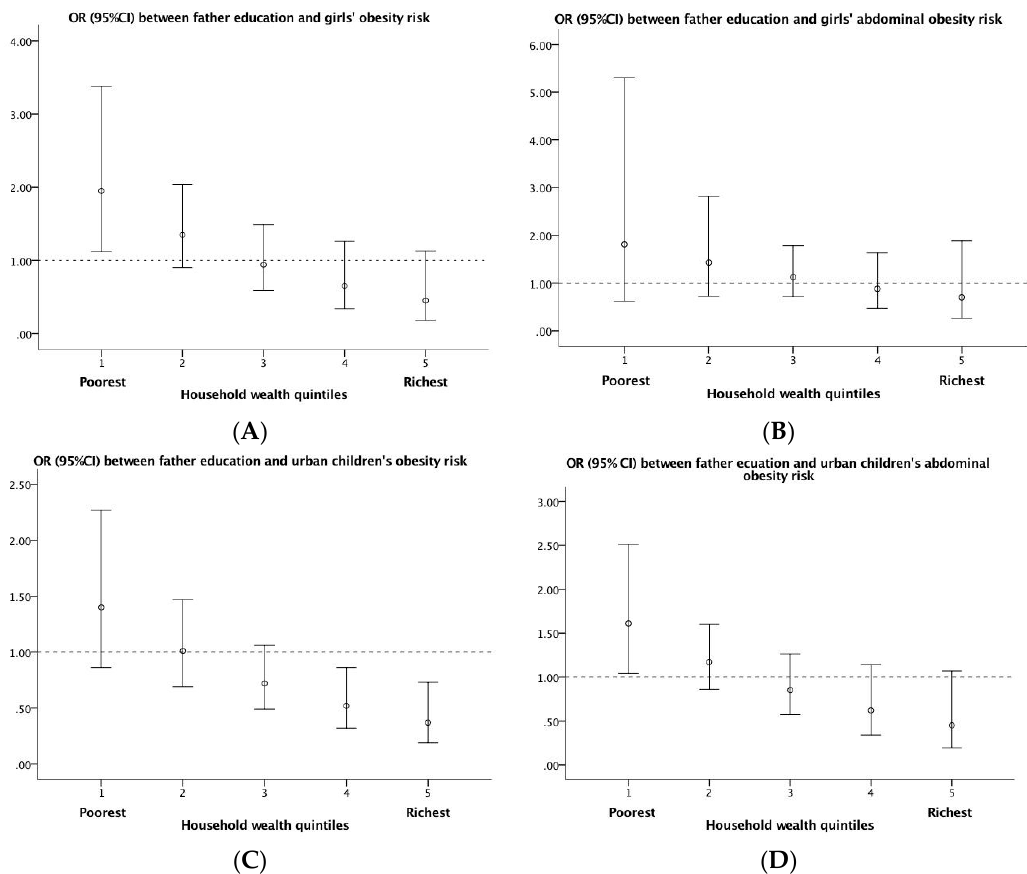
Figure 1. OR (95% CI) for father’s education level at different values of the household wealth quintile among girls and among urban children. ( A ) OR (95% CI) between father education and girls’ obesity risk; ( B ) OR (95% CI) between father education and girls’ abdominal obesity risk; ( C ) OR (95% CI) between father education and urban children’s obesity risk; ( D ) OR (95% CI) between father education and urban children’s abdominal obesity risk.